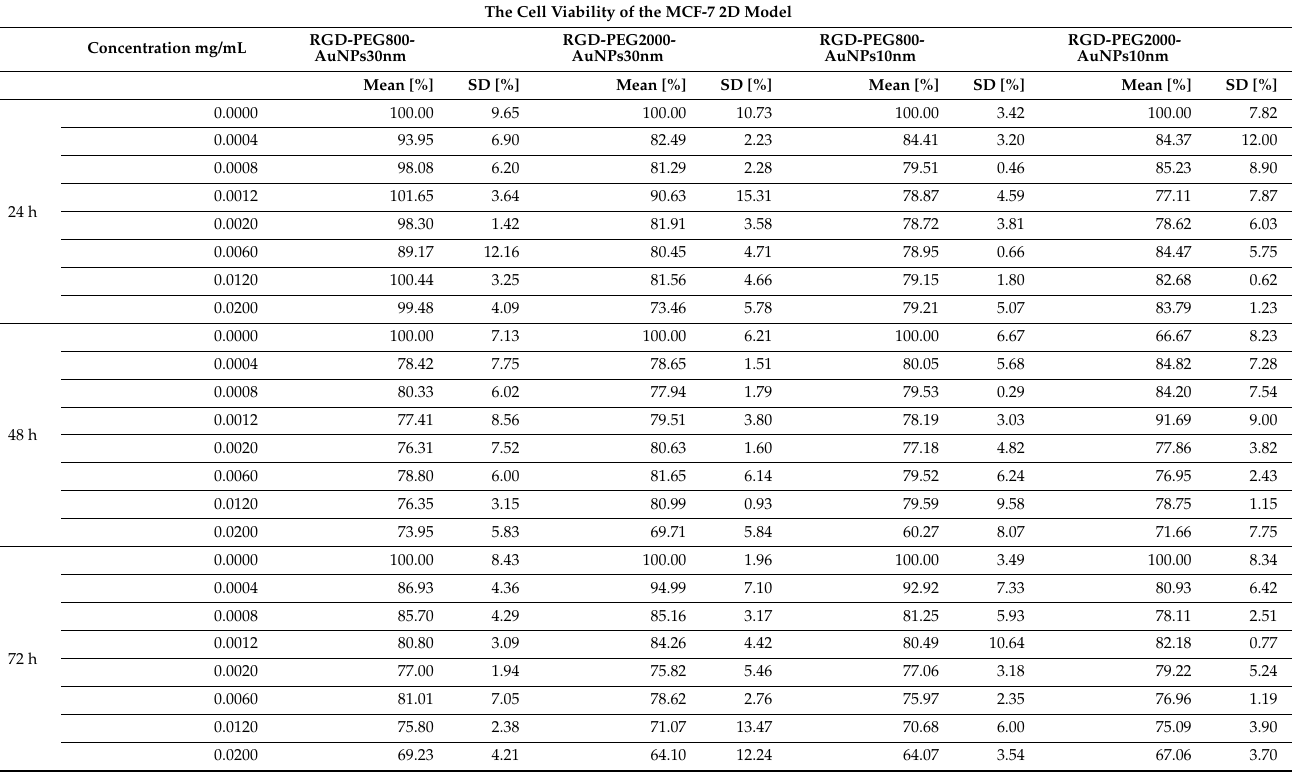
Table 1. The resume of the viability level of the MCF-7 2D model after incubation with AuNPs. In this test, RGD-PEG 800 -AuNPs 10nm , RGD-PEG 2000 -AuNPs 10nm , RGD-PEG 800 -AuNPs 30nm , and RGD-PEG 2000 -AuNPs 30nm were used in concentrations of 0.0004, 0.0008, 0.0012, 0.0020, 0.0060, 0.0120, and 0.0200 mg/mL. Abbreviations: SD—standard